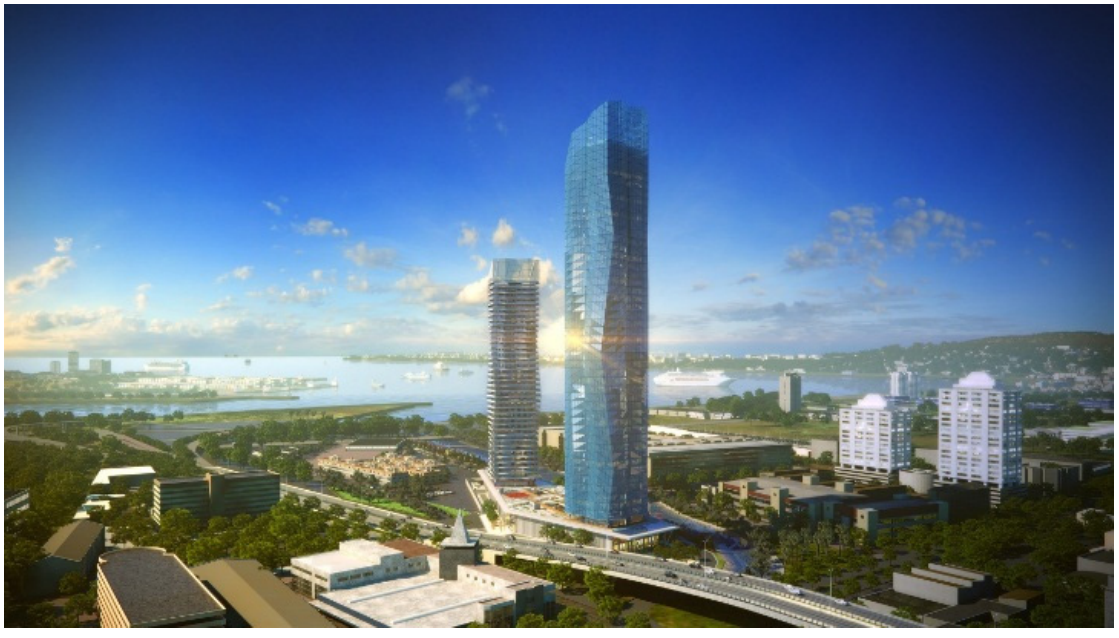
Figure 10. External View of Mistral İ zmir. Reproduced with permission from Bora Ş ahbazo ğ lu, published by DNA Mimarl ı k,